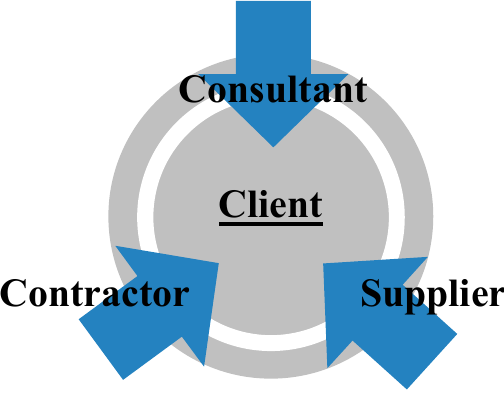
Figure 1. Key sources of a housing construction project.